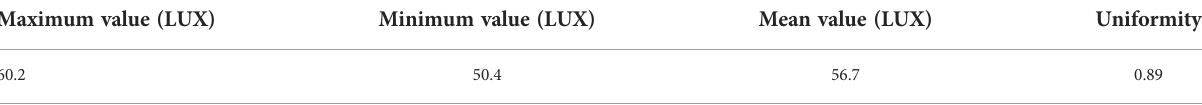
TABLE 3 The illumination distribution analysis with a lighting distance of